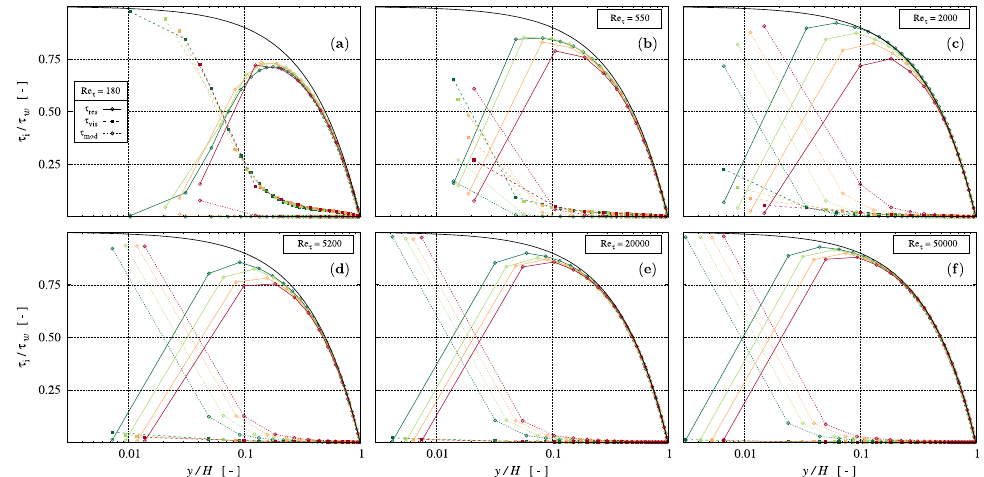
Figure 9. ( a – f ) Comparison of (averaged) non-dimensional resolved (solid/circles), viscous (dashed/squares), and modeled (dotted/diamonds) shear stress contributions extended by the linear total stress relation τ tot / τ w = 1 − y / H (solid black line) for all six investigated Re τ with four grids